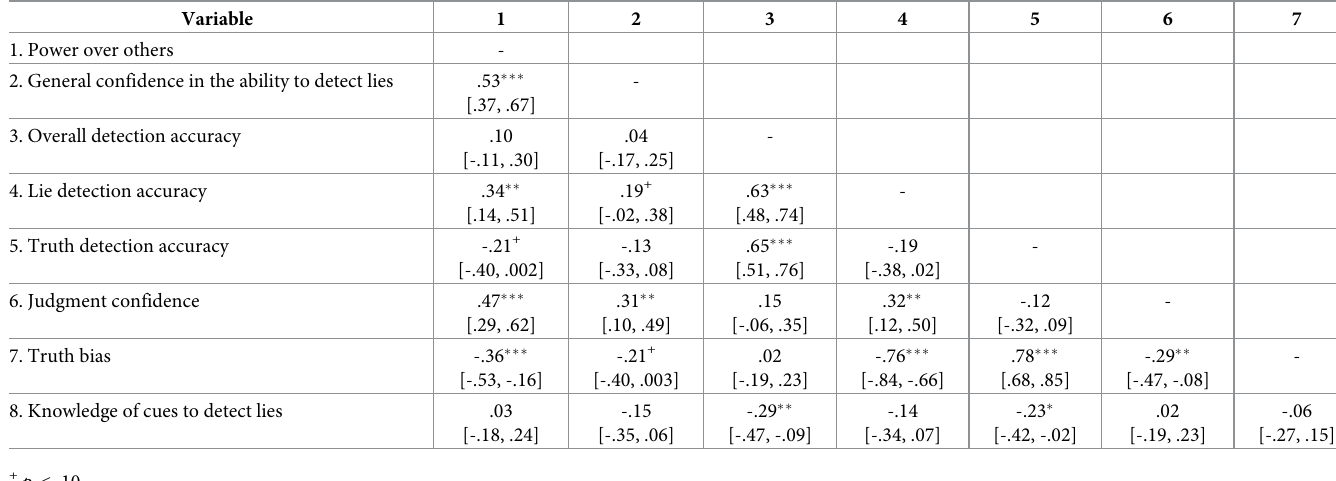
Table 1. Correlations between variables with 95% confidence intervals (Study